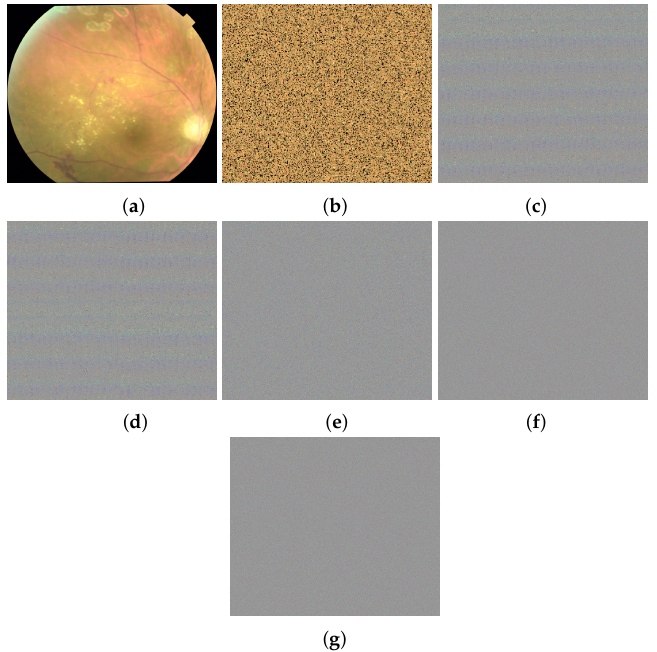
Figure 13. Results of the encryption algorithm applied to image 15 from the sick patients. ( a ) Original image. ( b ) First step: Jigsaw transform. ( c ) Second step: deterministic noise. ( d ) Third step: cyclic permutation. ( e ) Fourth step: Jigsaw transform. ( f ) Fifth step: deterministic noise. ( g ) Sixth step: Langton’s